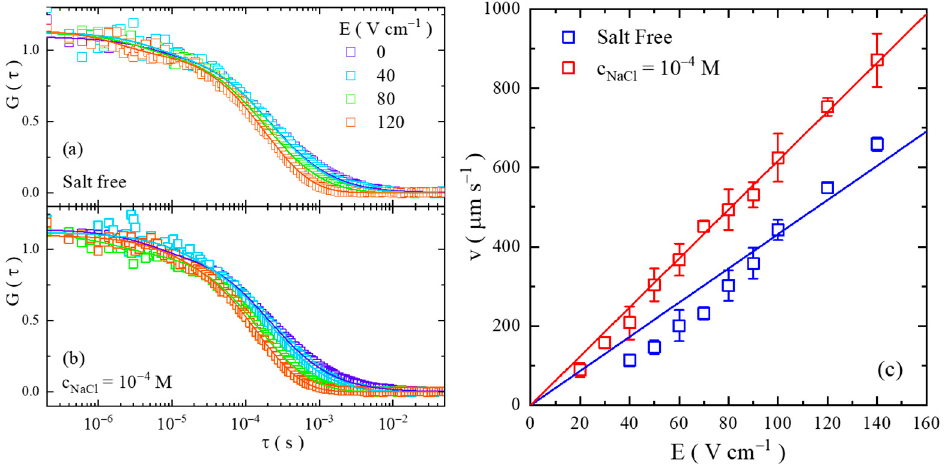
Figure 3. The auto-correlation function of PEO40k moving under the electric field. The values of the electric field strength are displayed accordingly in the figure. ( a , b ) are for the salt-free condition and salt concentration of 10 − 4 M, respectively. The solid lines denote the fitting results using a three-dimensional Brownian motion with directional motion. ( c ): the velocity of the PEO40k single chain ( 𝑣 ) as a function of the strength of the electric field ( 𝐸 ). The solid lines denote the fitting of linearity.